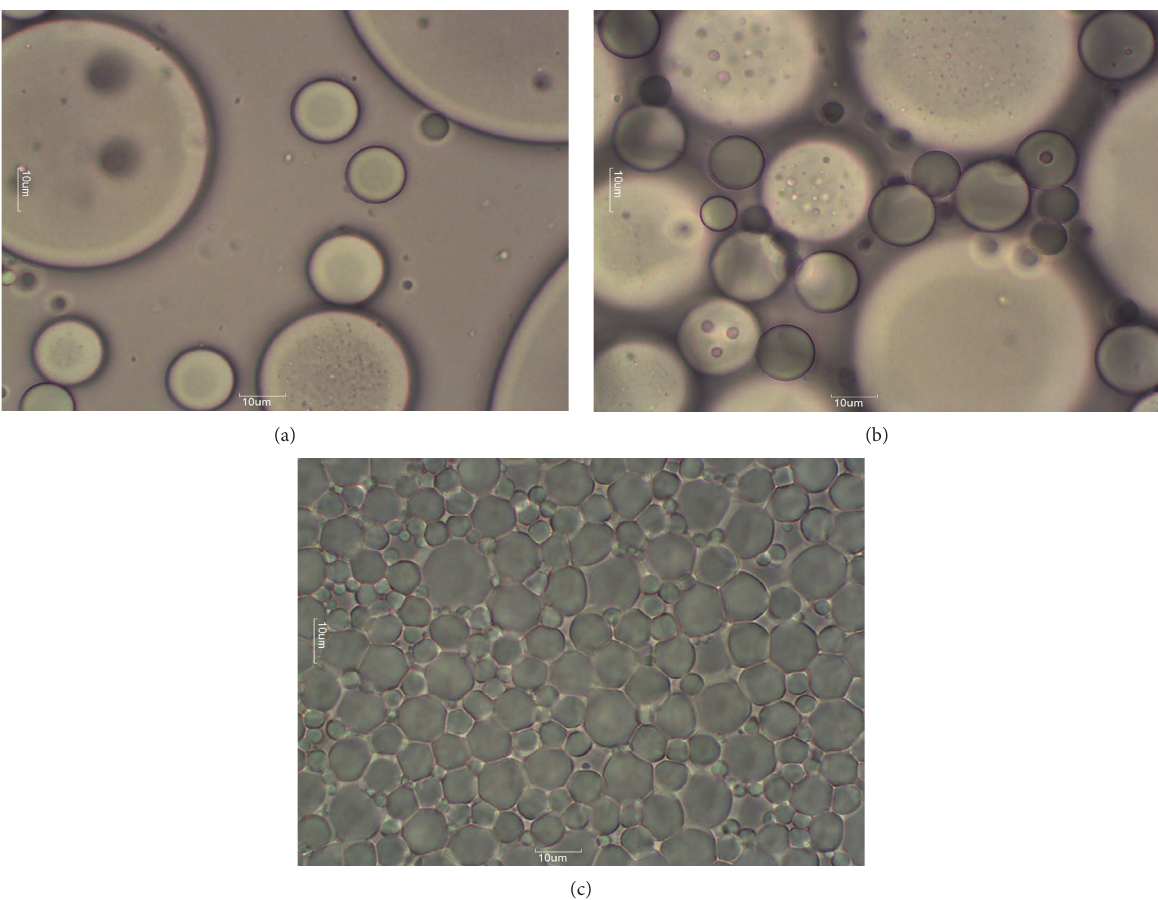
Figure 2: Optical microphotograph of O/W emulsions in the 60% w / w proximity window. As the concentration reaches the 60% w / w threshold, the average distance between droplets is reduced and adjacent droplets are more common. (a) 50% w / w . (b) 60% w / w . (c) 80% w / w . Scale 10 µ m.